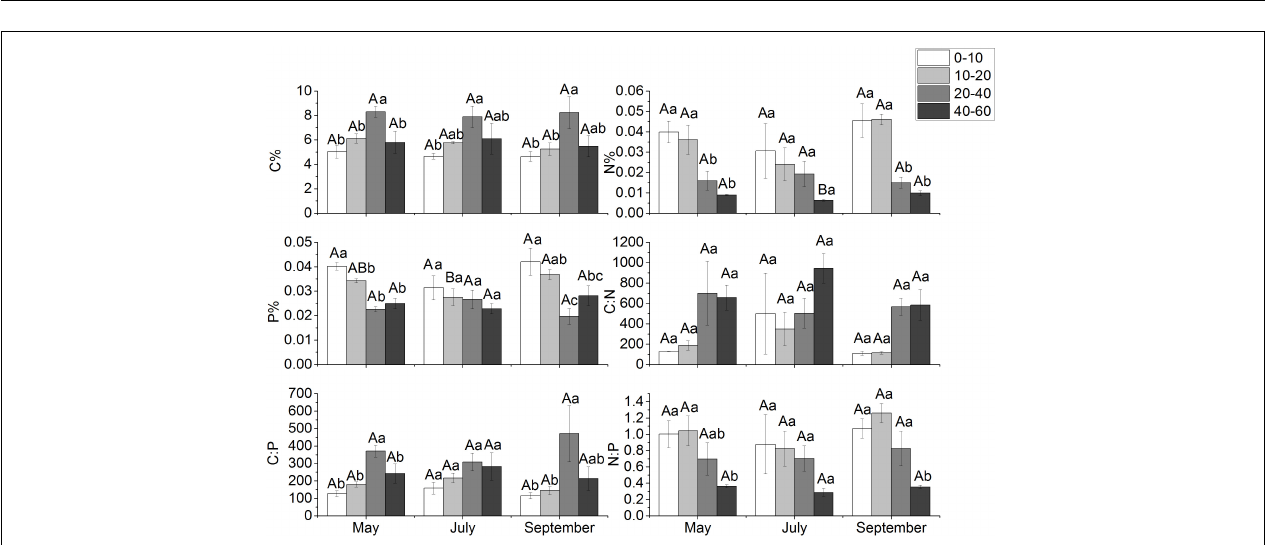
FIGURE 3 | Relationships between season, water use efficiency, and C, N, P content in the leaves of M. sibirica. Solid lines are statically different at P < 0.001, while dotted lines are not significant at P > 0.05.